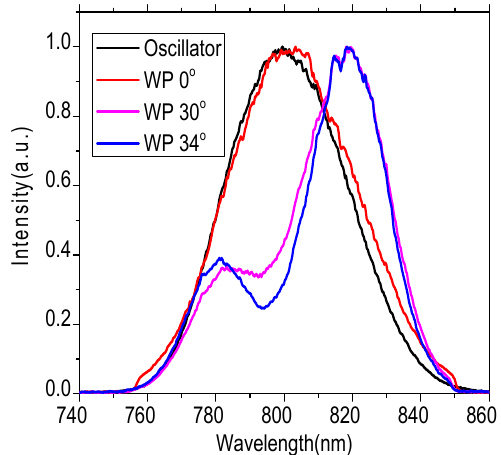
Figure 5. The spectra of the oscillator and the spectra of the seed beam before the regenerative amplifier for different rotation angles of the WP.